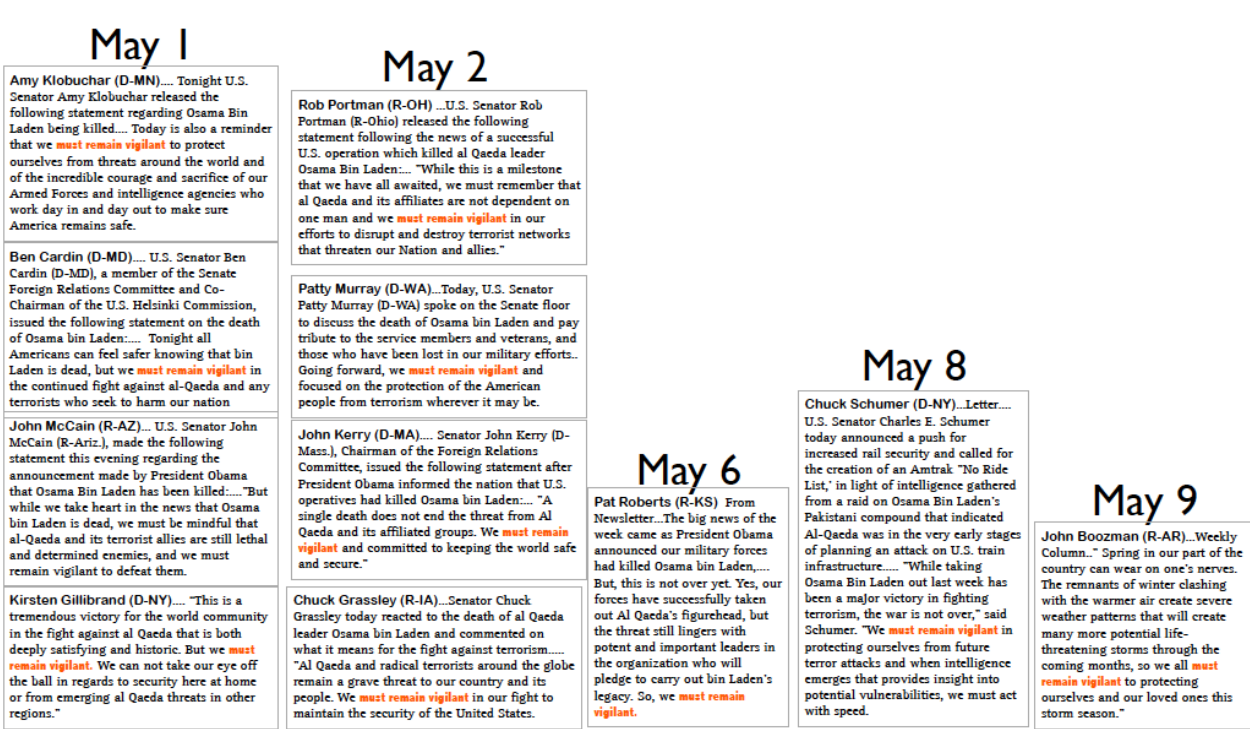
Figure 7. The trigram “must remain vigilant” appeared frequently in the press release over the week after Bin Laden’s